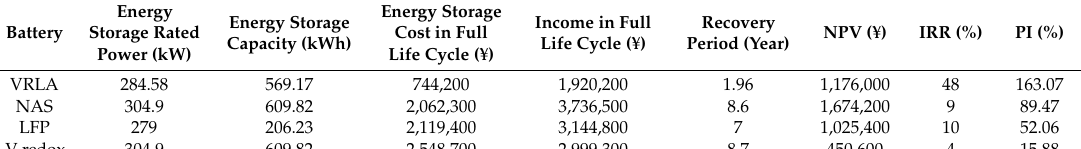
Table 6. Energy storage configuration and economic evaluation results of demand response.